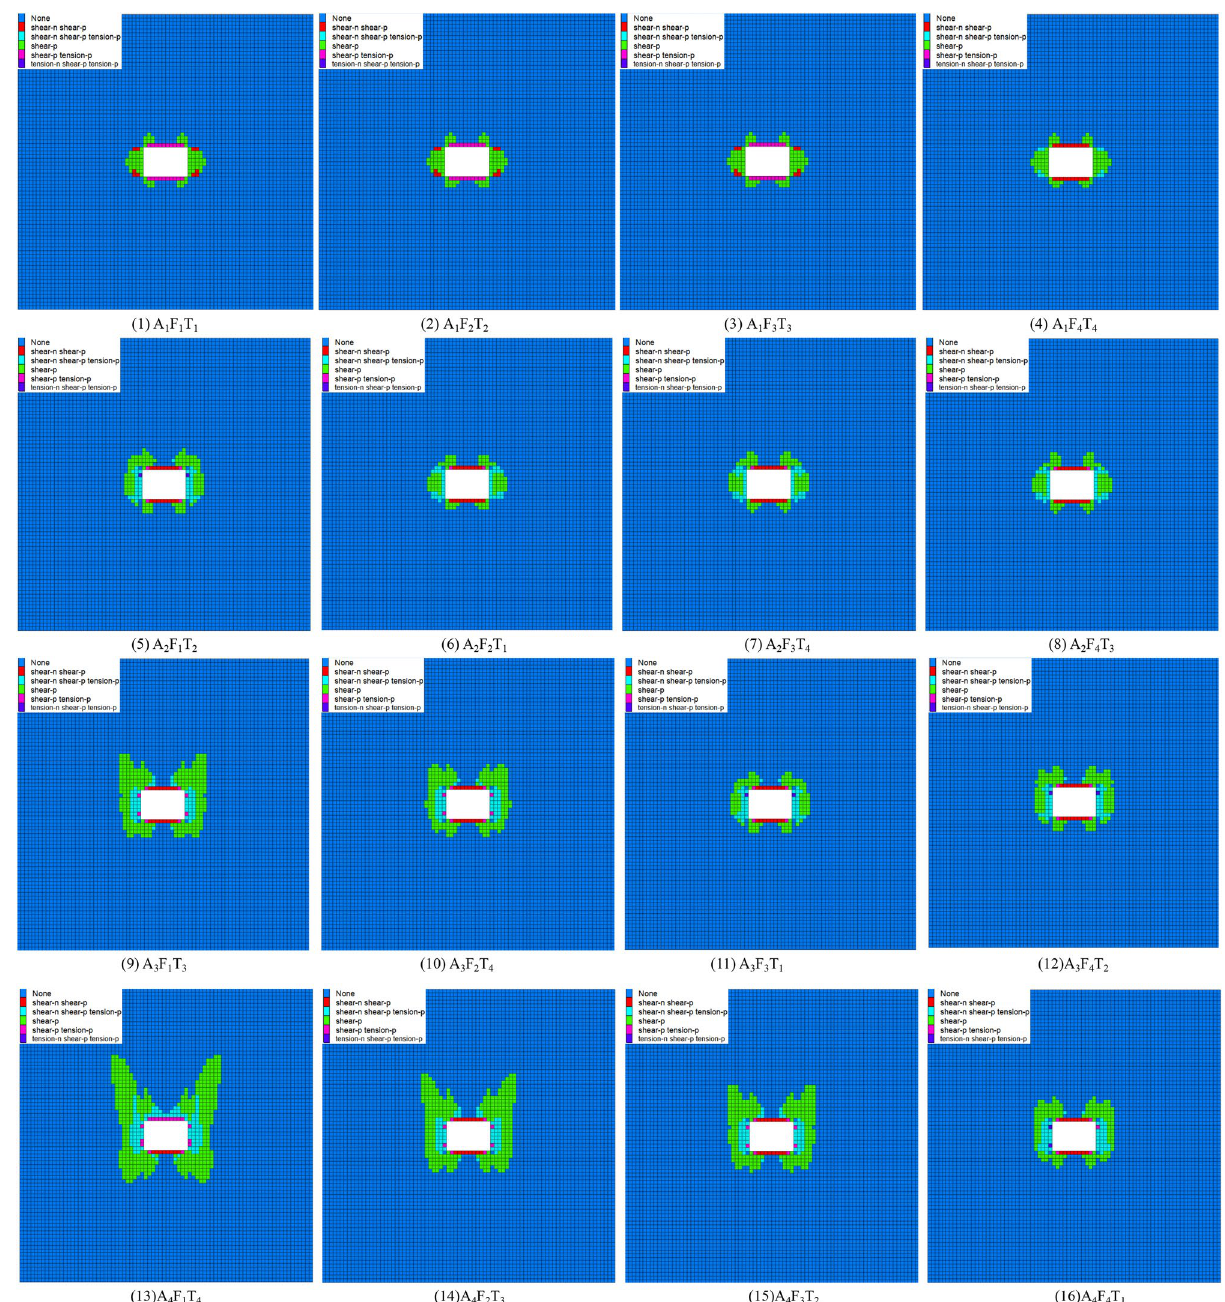
Figure 16. Failure of surrounding rock under the different